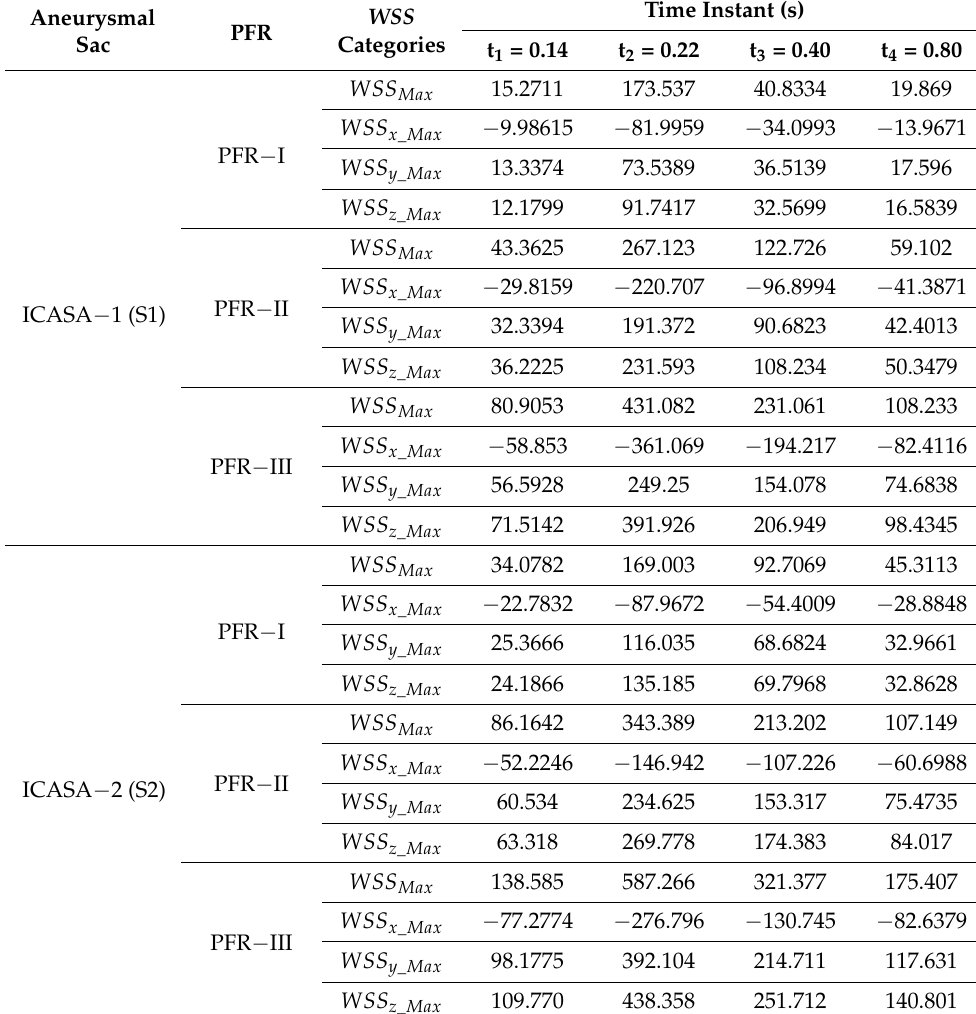
Table 2. Maximum instantaneous WSS (Pa) in the aneurysm sacs (S1 and S2) under the bifurcated shunt ratio q A1 :q A2 = 75:25 and different PFRs at designated time instants. Time Instant WSS Aneurysmal PFR Categories Sac